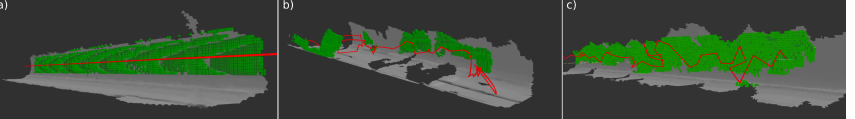
Figure 8. Example of executed inspection trajectories for each method in the simulated tunnel environment. Sensed voxels are marked in green. ( a ) Wall-following trajectory. ( b ) TSDF Informed RRT* [30]. ( c ) Proposed method.